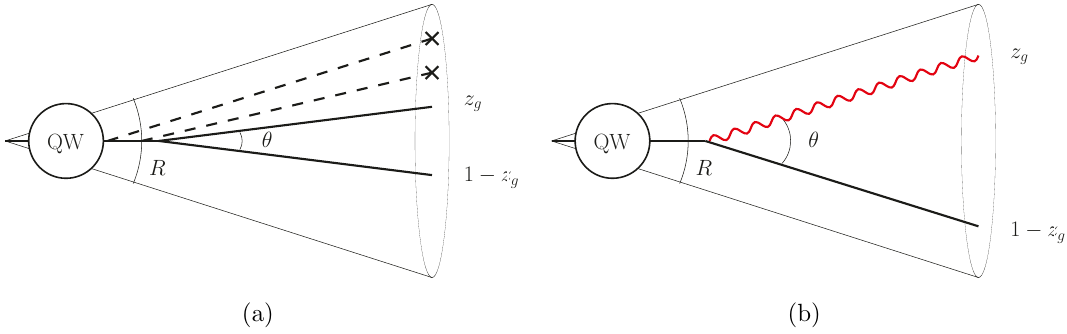
Figure 1. Coherent energy loss. The blob on the (cid:12)rst propagator illustrates the coherent energy loss of the jet which does not a(cid:11)ect the groomed jet structure. Its range extends however along the whole in-medium path length. (a) Vacuum radiation, including real, groomed emissions that are marked by a cross. (b) Hard, quasi-collinear medium-induced radiation (depicted by a red, wavy line) emitted inside the jet